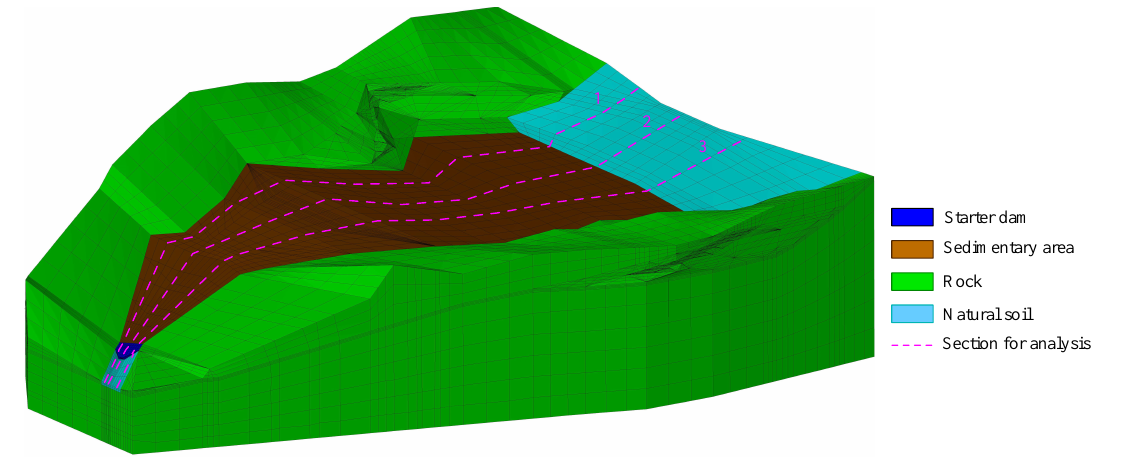
Figure 7. The 3d finite element mesh of the tailings dam with the equivalent drainage structure. The dashed lines are employed to illustrate the section location for analysis.